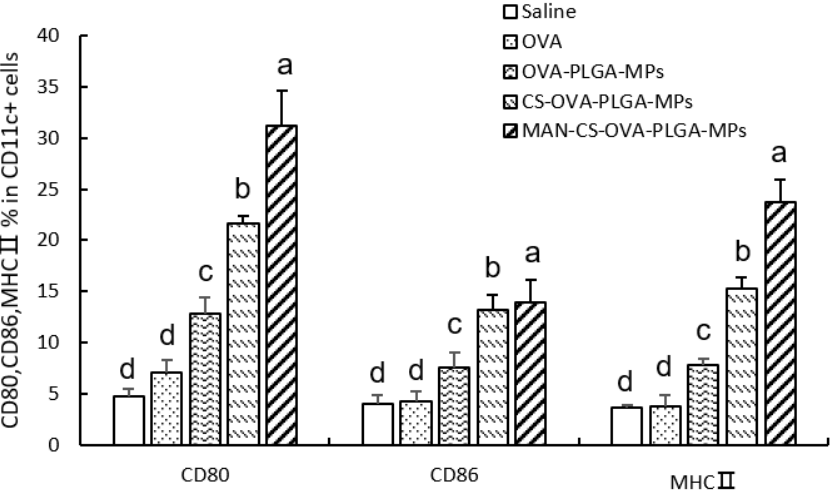
Figure 9. Effect of MAN-CS-OVA-PLGA-MPs on the expression of DC surface molecules in the spleen of mice immunized for 24 h. The spleens were removed from immunized mice on day 3 following the first immunization, and splenocyte suspensions were prepared. The cells were double-stained with anti-CD11c-FITC and anti-MHC II-PE, anti-CD11c-FITC and anti-CD80-PE, or anti-CD11c-FITC and anti-CD86-PE. Then, the expression levels of surface molecules (MHC II, CD80 + , and CD86 + ) were analyzed using FACS. FITC-stained positive cells represent DC cells. The PE-stained positive cells represent the cells that expressed surface molecules. The PE and FITC double-positive cells identified the DCs that expressed surface molecules. The percentage of PE and FITC double-positive cells were selected and recorded in each sample as well as the percentage of MHC II, CD80 + , and CD86-positive DCs compared to total DCs. Data are presented as means ± SD ( n = 3), with different letters (a–d) indicating significant differences ( p < 0.05).